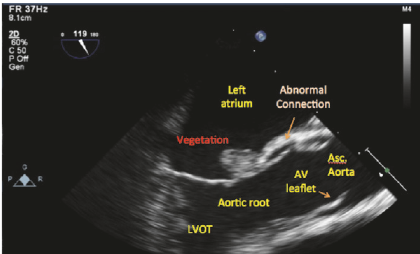
Figure 5: Axial image of the aortic root abscess demonstrating a possible fistula between the aorta and the right atrium.